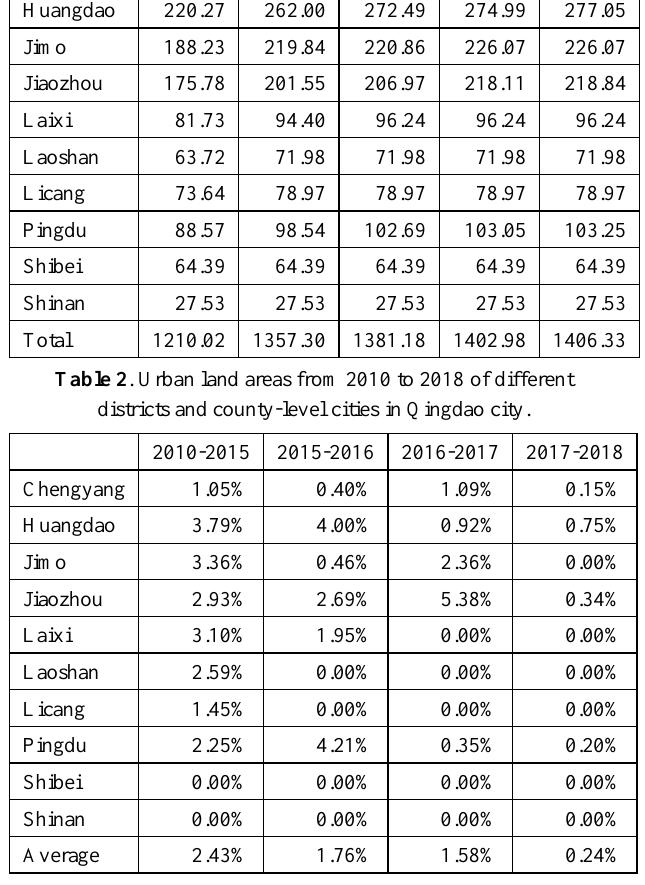
Table 3 . The annual urban land expansion rates of differentdistricts and county-level cities in Qingdao